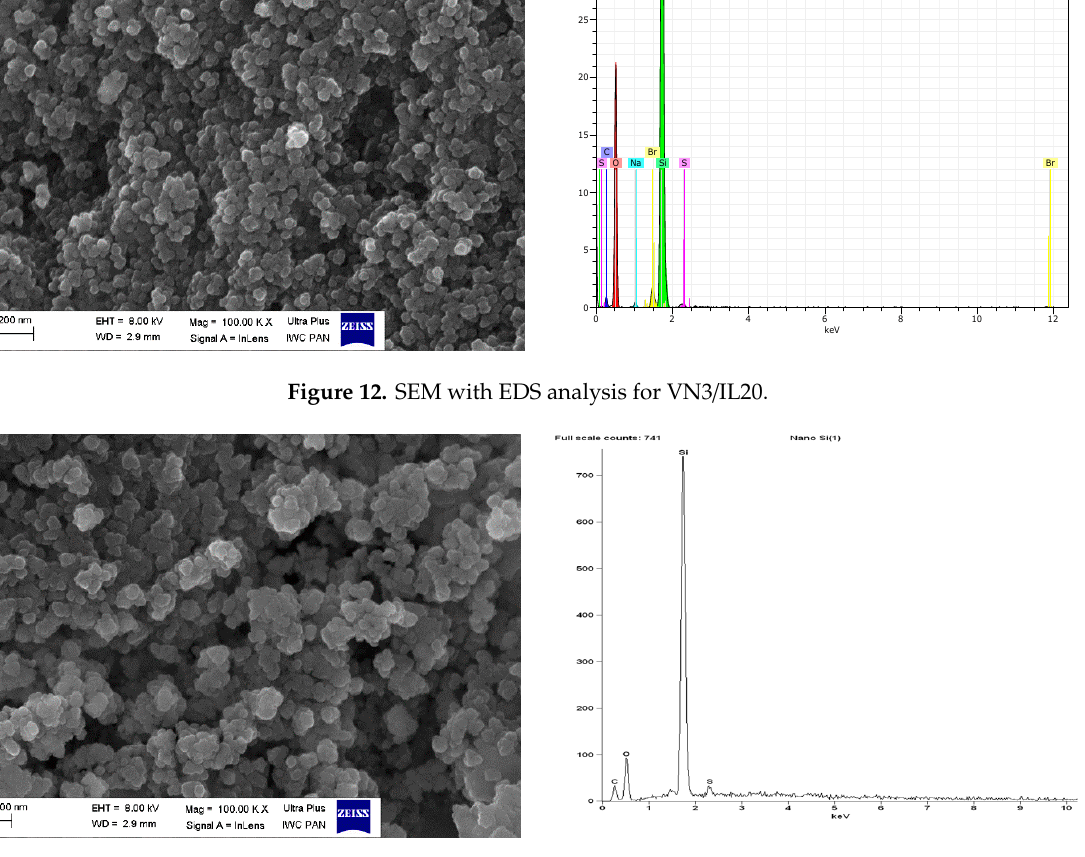
Figure 14. SEM with EDS analysis for nanoSiO 2 /IL20.